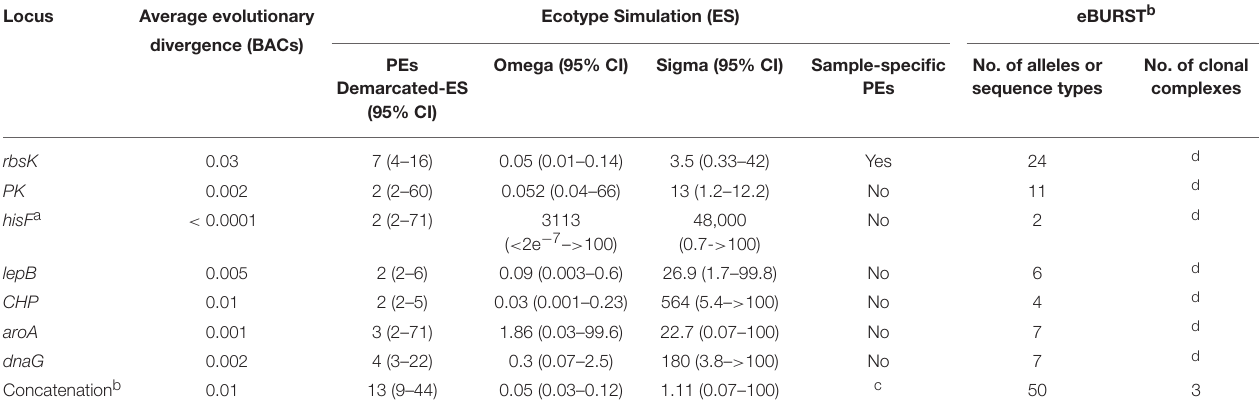
TABLE 4 | Ecotype Simulation and eBURST output for 71 A-like Synechococcus BACs that contained all 7 loci assayed for the study. Locus Average